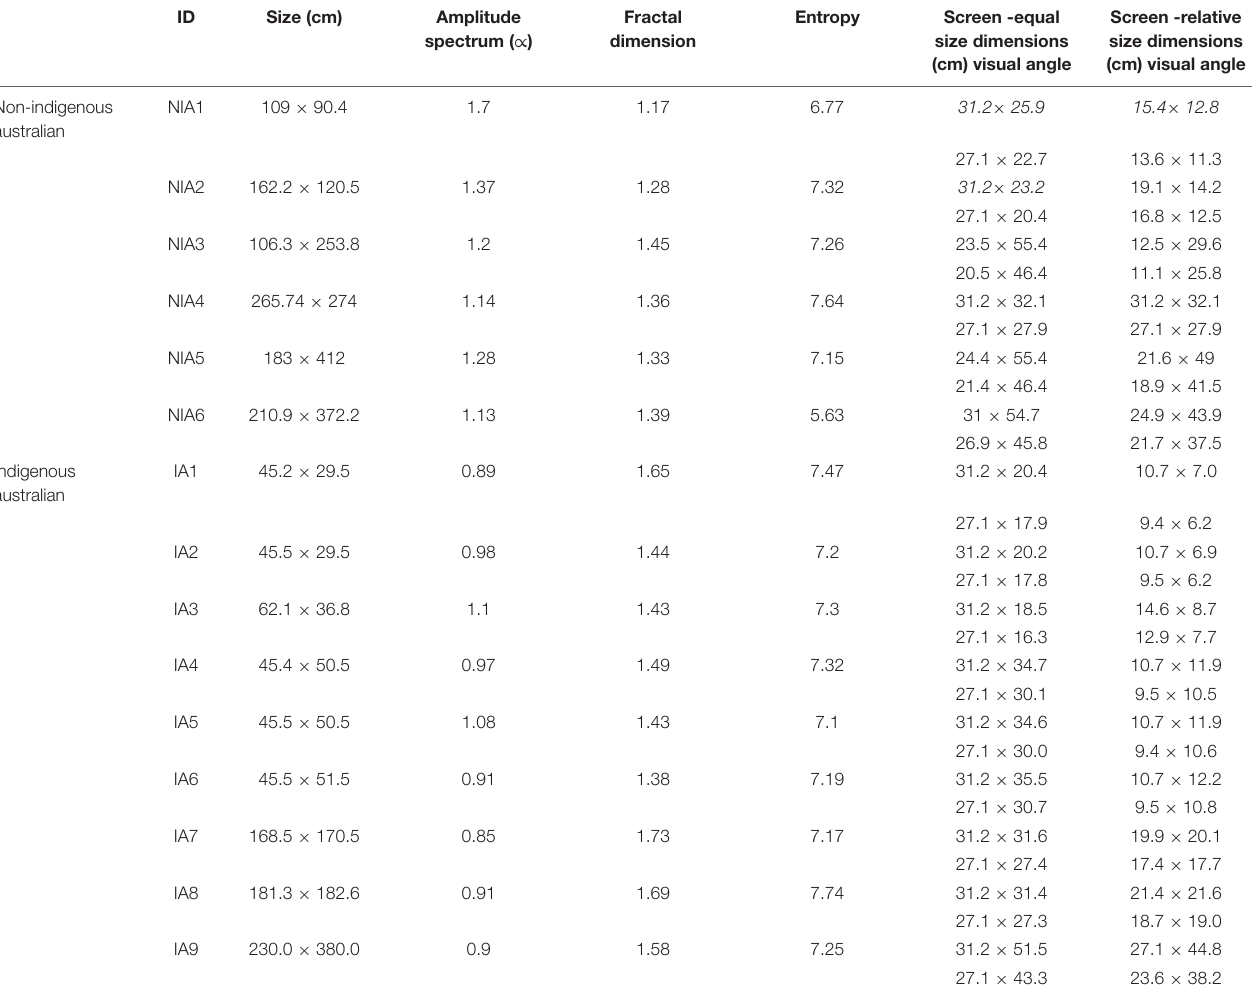
Fractal Entropy Screen -equal Screen -relative spectrum ( ∝ ) dimension size dimensions size dimensions (cm) visual angle (cm) visual angle